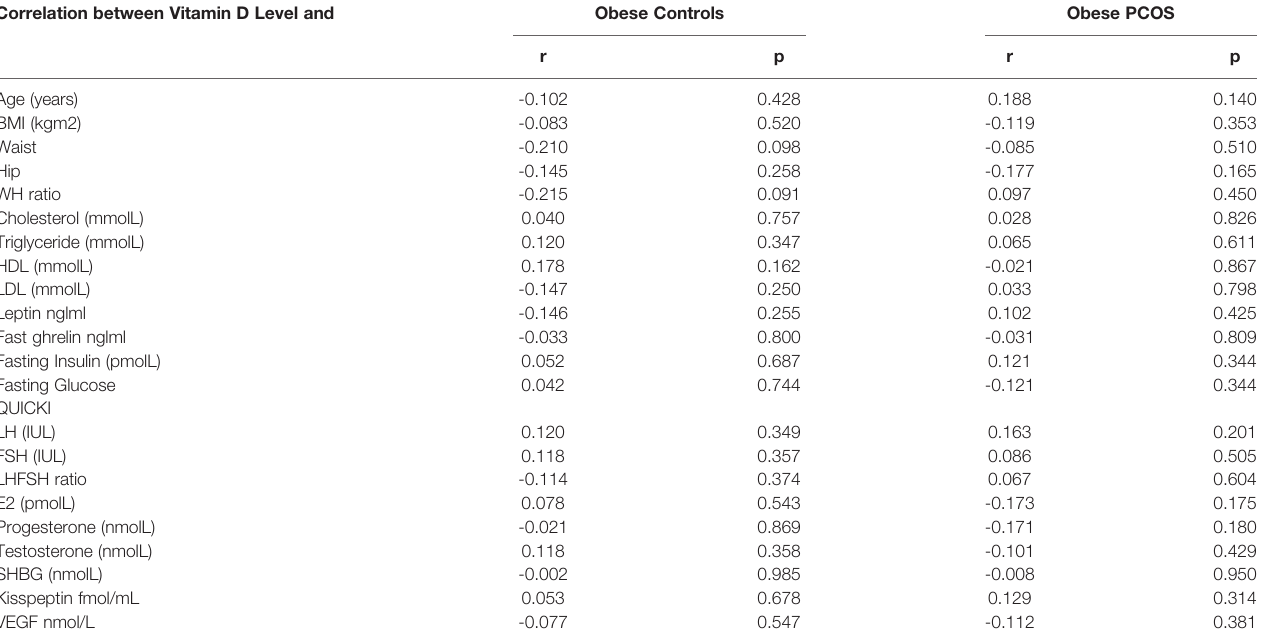
TABLE 3 | Correlations between Vit D and the studied parameters in obese PCOS and obese non-PCOS controls. Correlation between Vitamin D Level and Obese